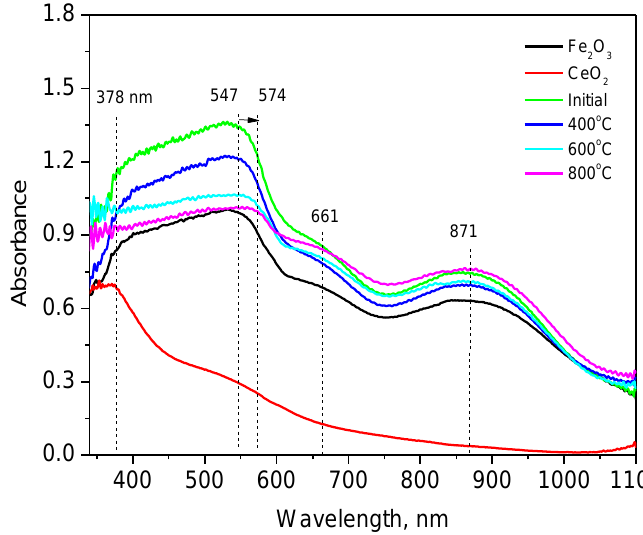
Figure 7. Dynamics of change in the absorption spectrum of studied nanoparticles.